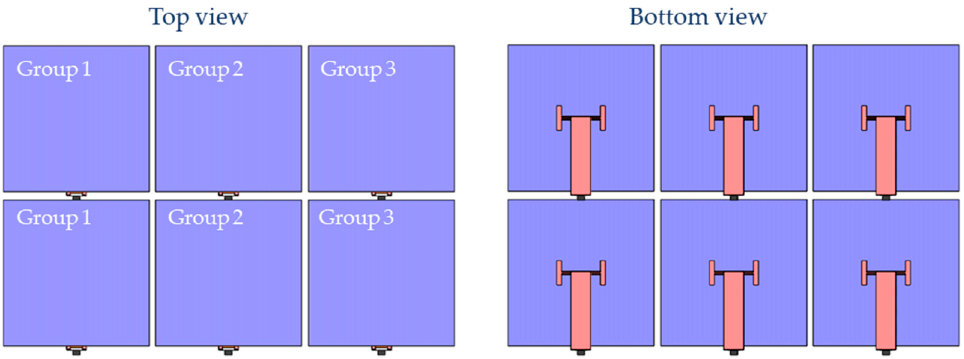
Figure 11. Arrange deformed squamae in an array to form deformable skin.